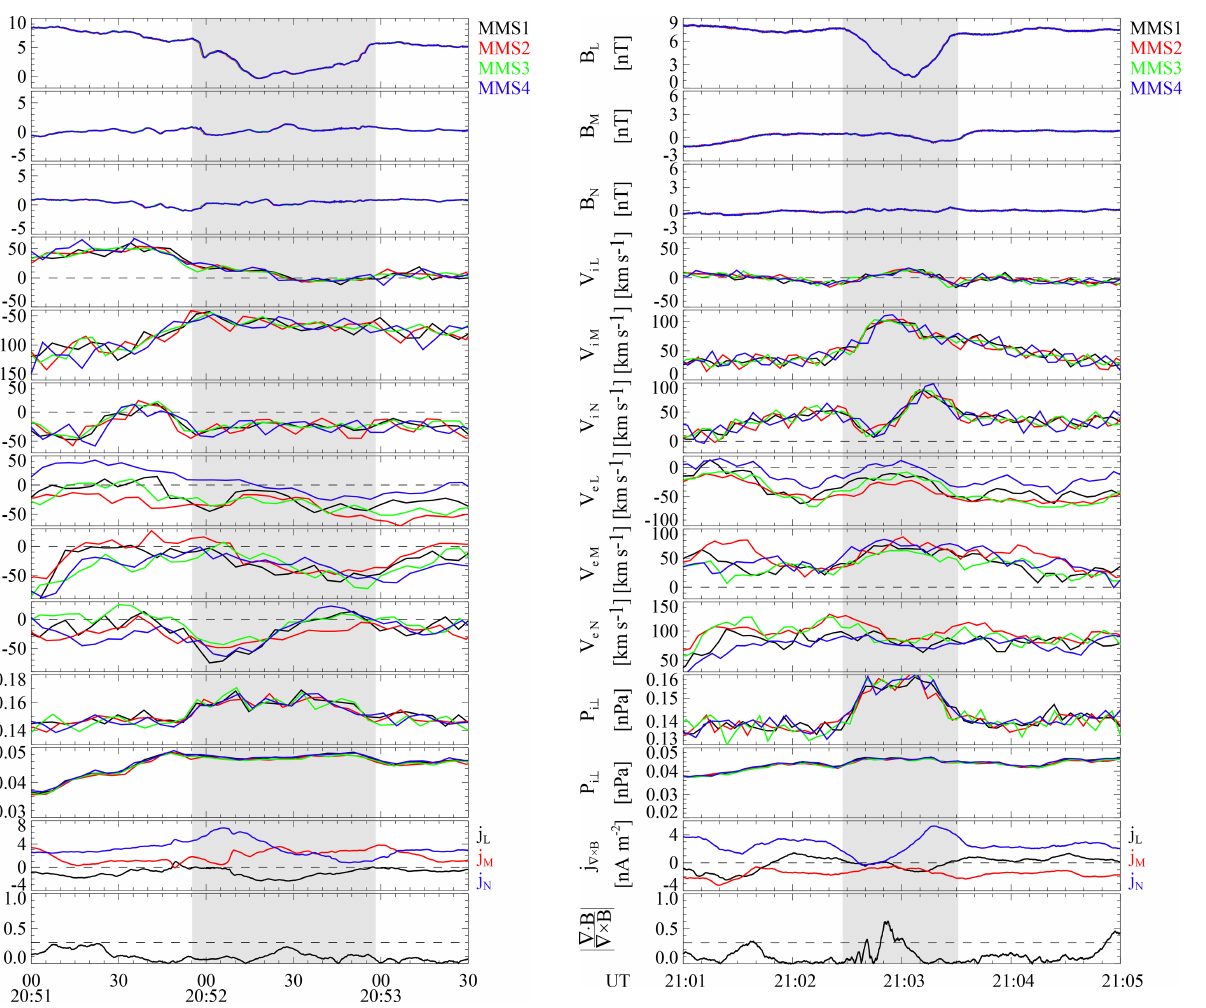
Figure 3. From top to bottom: three components of the magnetic field, ion and electron velocities in LMN, the ion and electron per- pendicular thermal pressures, the current density in LMN, and the ratio of |∇ · B | / |∇ × B | between 20:51 and 20:53:30UT. The black, red, green, and blue colors indicate data obtained from MMS1, MMS2, MMS3, and MMS4, respectively. The current density is calculated by the curlometer technique. The gray region indicates the interval of the magnetic dip.